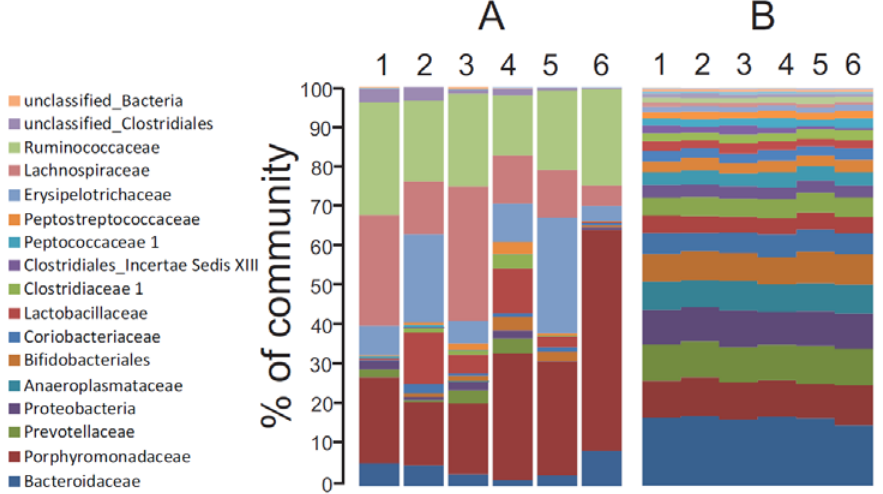
Figure 1. ( A ) Distribution of phylotypes (% of total) at the family taxon level in the fecal and cecal communities of rats fed each diet. Family taxa are identified on the left of panel A. The phylum Proteobacteria encompasses the families Desulfovibrionaceae